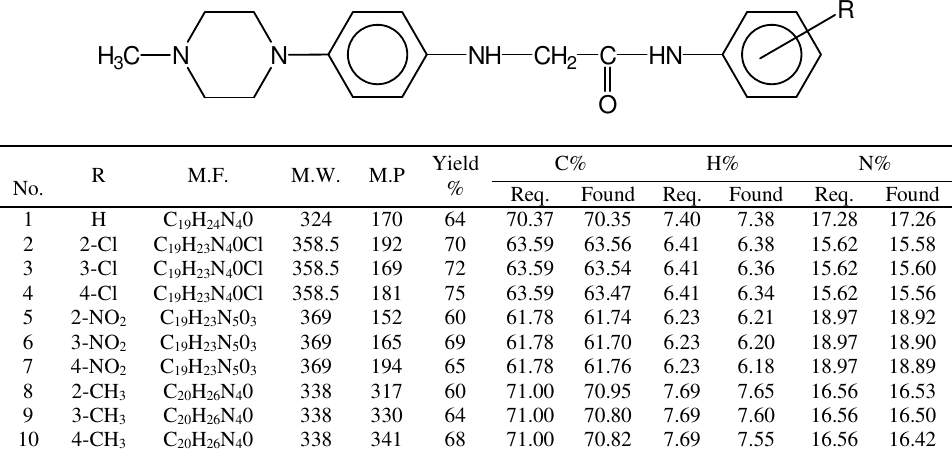
Table - 2. Physical, analytical data and antibacterial activity of 1-[2-(Aryl amino-2-oxo ethyl) amino]-4- (N-methyl piperazino)-benzene